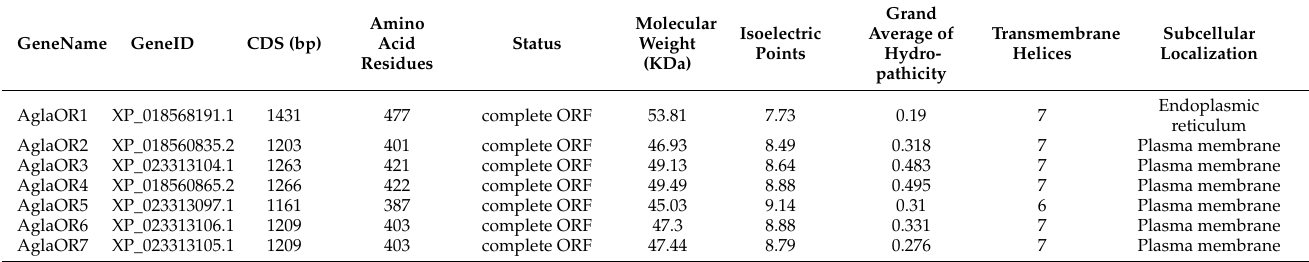
Table 1. Summary information of OR gene family in Anoplophora